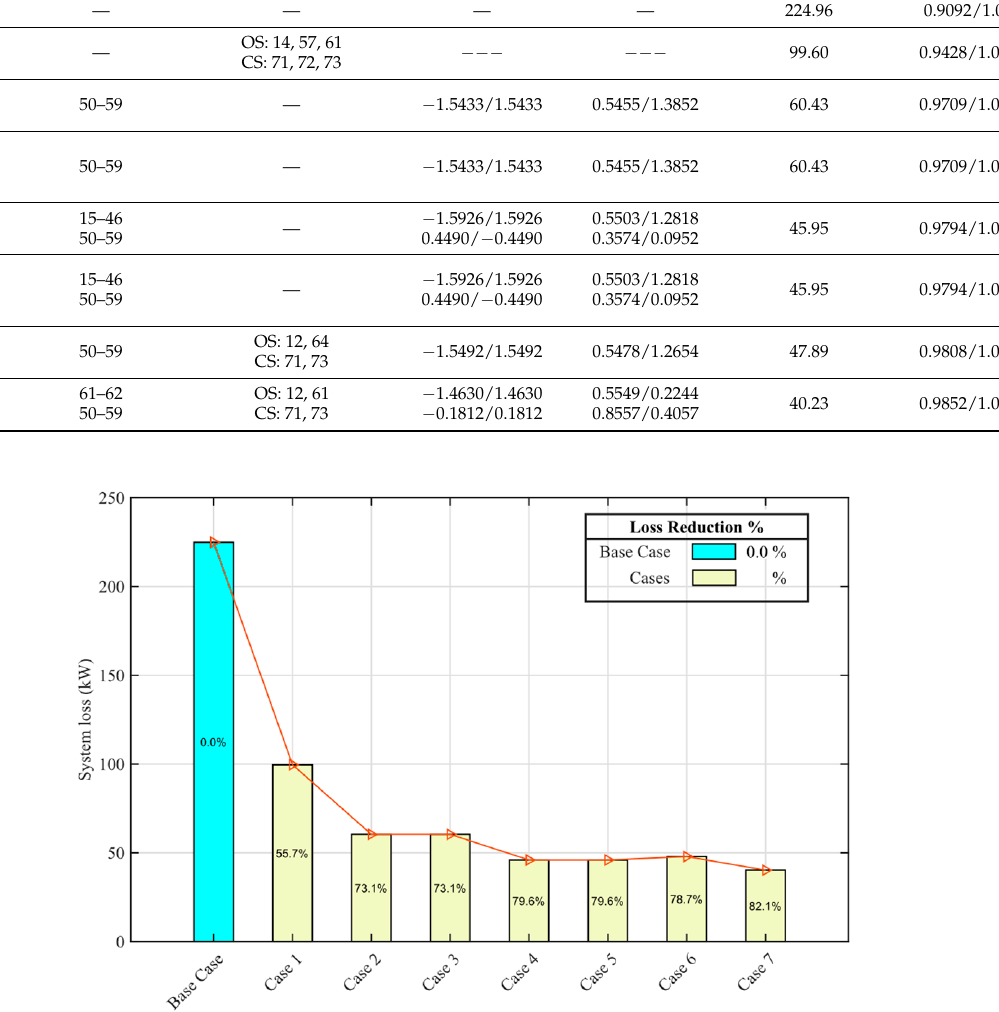
Figure 9. Loss reduction improvement profile of the 69-node test DS for all cases. The voltage profile curve for each case, including the basic case, is compared and shown in Figure 10. Except for the base case and case 1, this figure shows that the voltage magnitudes for all system nodes are all within acceptable boundaries. Notwithstanding, as a result of the search space being heavily confined by the radial topology of the test system in case 1, the HWCA is unable to find the optimal solution while keeping all system nodes within permitted